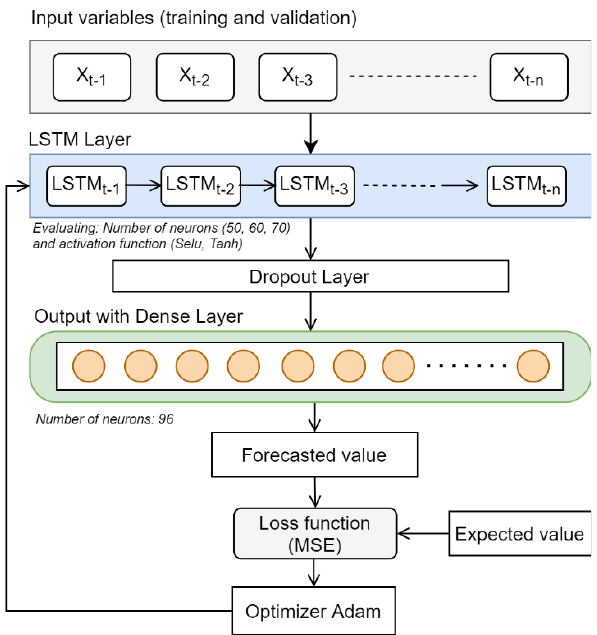
Figure 6. Architecture proposal and training flow of the model for forecasting the daily energy consumption of the HVAC system in buildings.